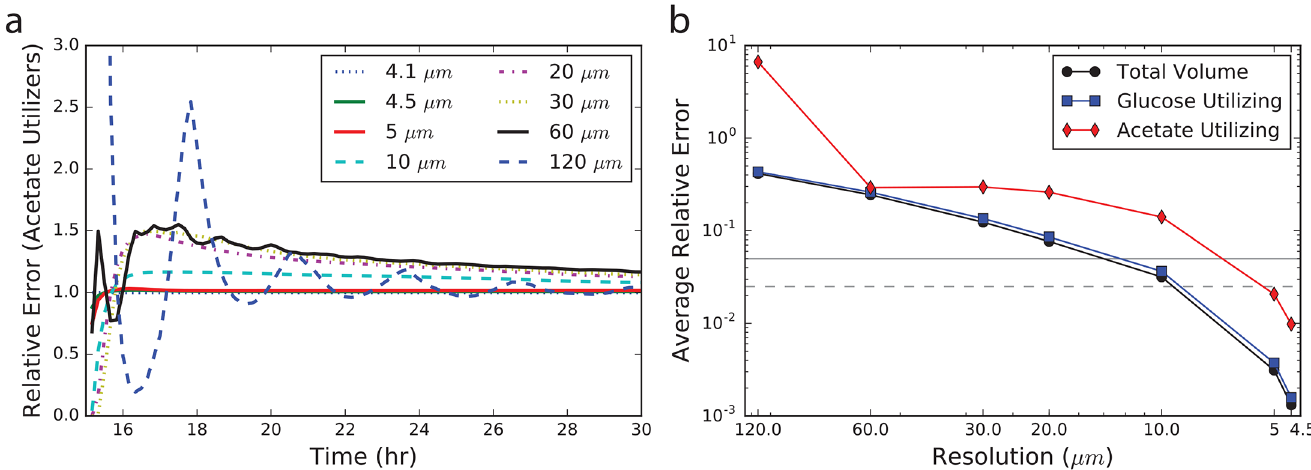
Fig 4. Error analyses. a) Error in the acetate utilizingpopulation fraction, relative to the 4.1 μ m simulation, after the emergence of metaboliccooperativity (occurring at about 15 hours). Coarse resolutions introduce numericaloscillations when coarser than about 20 μ m. b) Error in the computedvolume of cells in an E. coli K-12 MG1655 colony as a function of grid resolution. Errors are computedas the relativedeviationfrom a simulationwith a 4.1 μ m grid resolution averagedfrom 10 to 30 hours of colony growth. Total colony volume (black circles), volume of glucoseutilizingcells (blue squares) and volume of acetate utilizingcells (red diamonds) are shown. Horizontallines show 5% (solid) and 2.5% (dashed)error in the volumes.